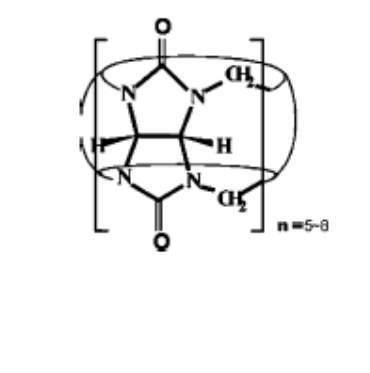
Figure 1 . Structures of the cucurbit[ n=5-8